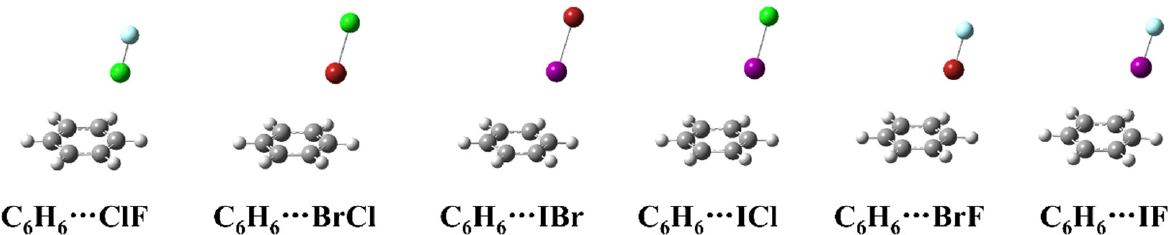
Figure 1. The geometric structures of the complexes between heteronuclear halogen and benzene.